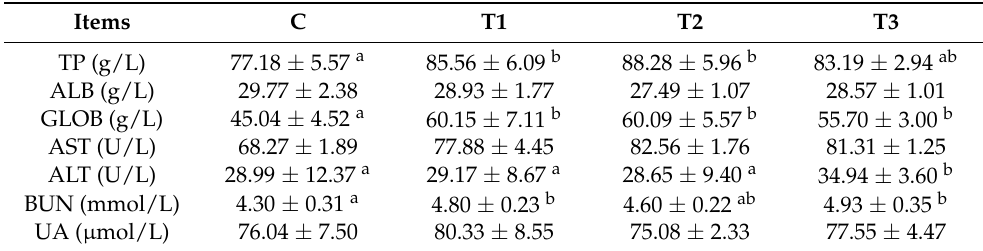
Table 5. Effects of dietary BM1259 on blood metabolites in lactating dairy cows. Items C